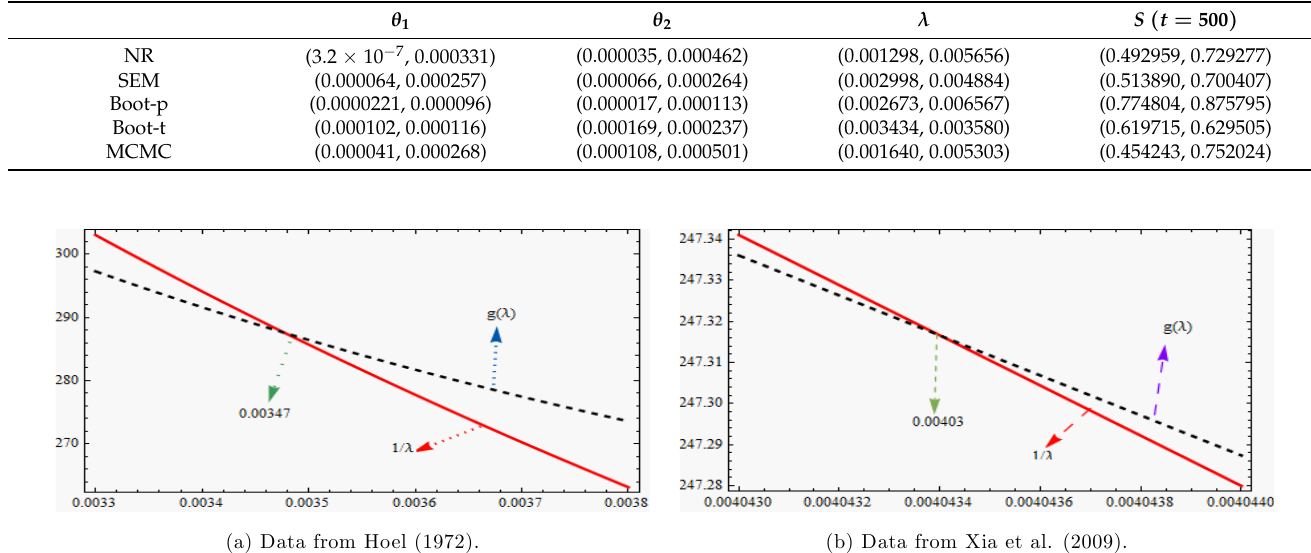
Table 3. Point and interval estimates of θ 1 , θ 2 , λ and S(t) for the data from Hoel (1972).